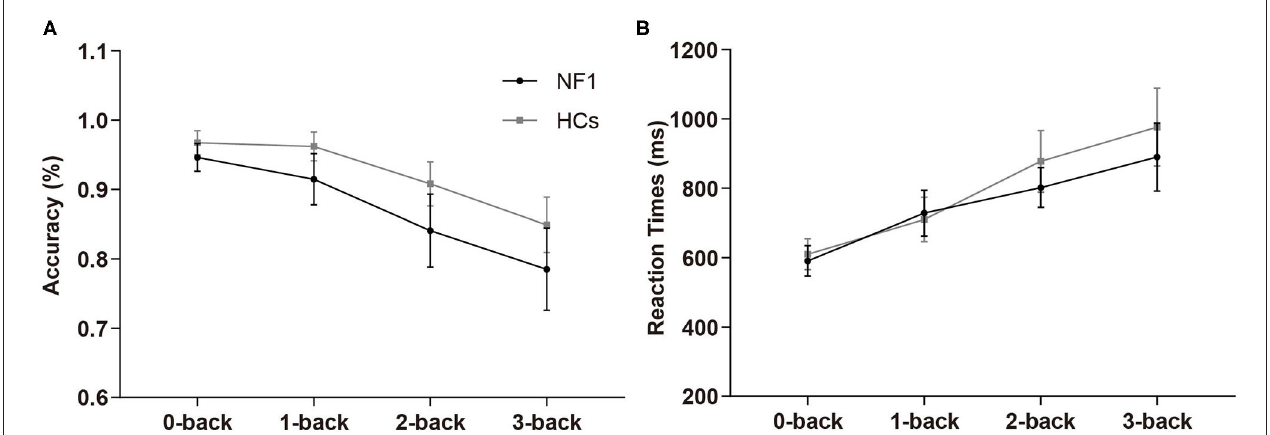
FIGURE 3 | Results of accuracy (A) and reaction times (B) in the verbal N-back task. No difference was found in verbal WM between adult patients with NF1 and HCs. Error bar was 95% confidence interval. HCs, healthy controls; NF1, neurofibromatosis type